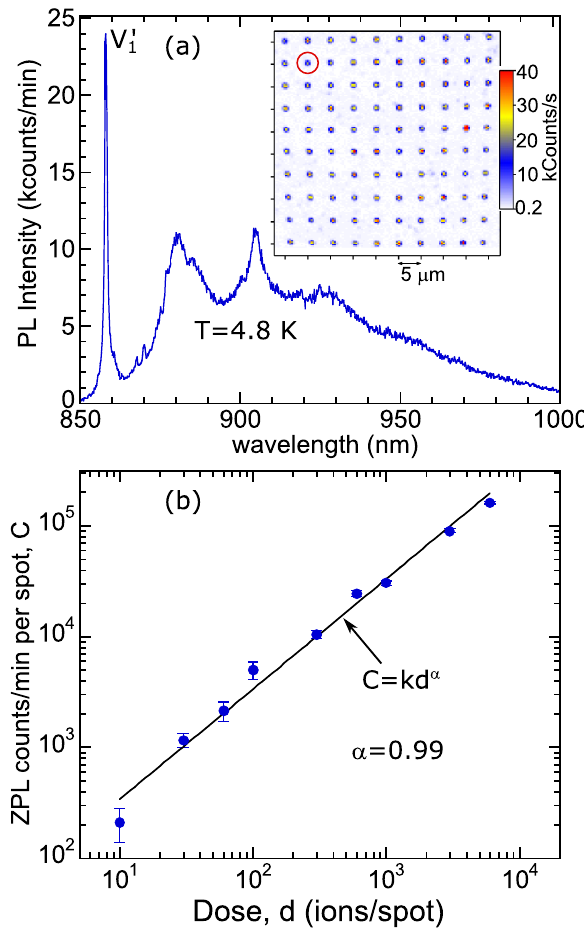
Figure 1. ( a ) Background subtracted PL spectrum at 4.8 K acquired from an individual spot of a 10 × 10 array implanted at a dose of 1.2 × 10 14 ions/cm 2 (600 ions/spot) which is identified (red circle) in the LT confocal fluorescence map (inset). ( b ) Mean V ′ 1 ZPL counts (circles) as a function of Li + implantation dose, along with a fit to a power law, C = kd α . Error bars represent twice the standard error of the